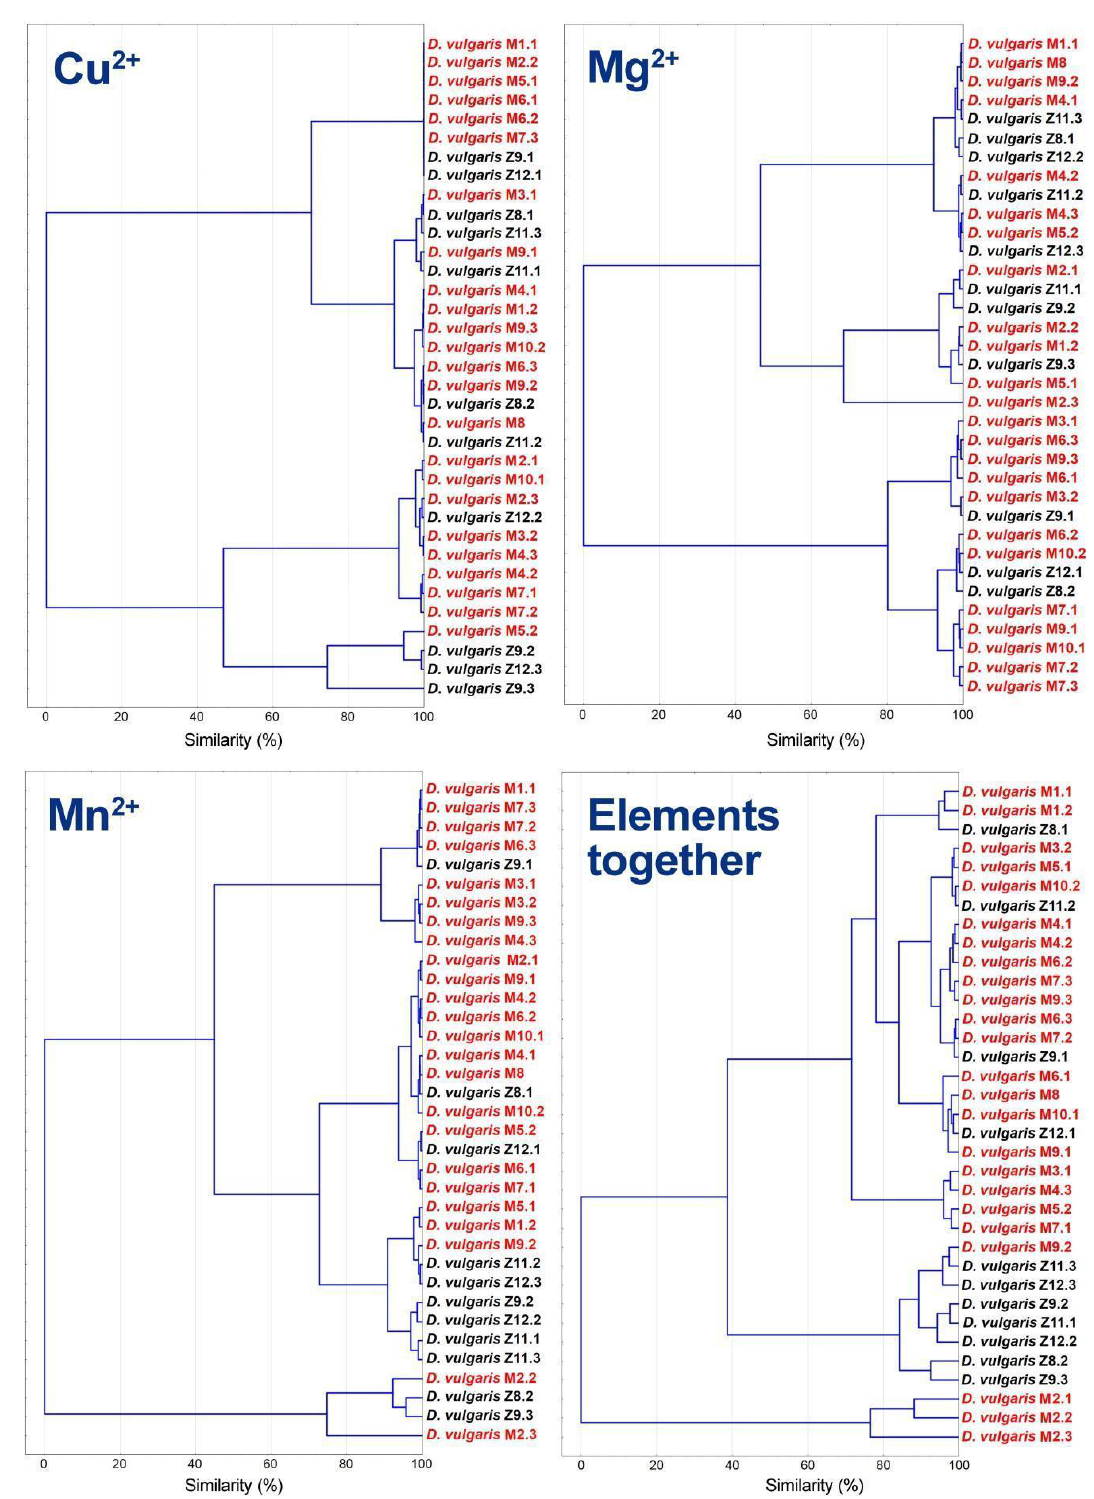
Figure 7. Cluster analysis based on concentrations data of physiological important elements (Cu 2+ , Mg 2+ , Mn 2+ and all described elements in the previous and present figures).